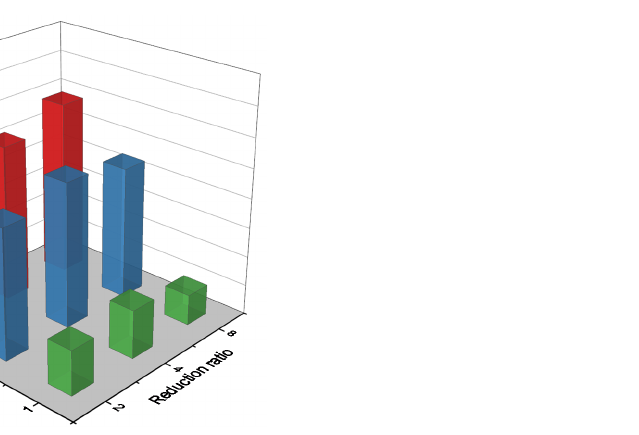
Figure 5. Accuracy comparison on different EEGNet blocks with different reduction ratios in SE block.